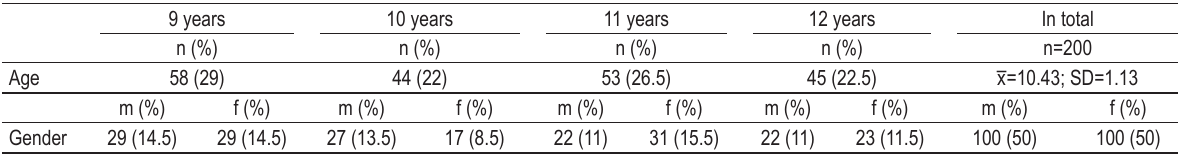
TABLE 1. Descriptive characteristics from the sample of the test groups